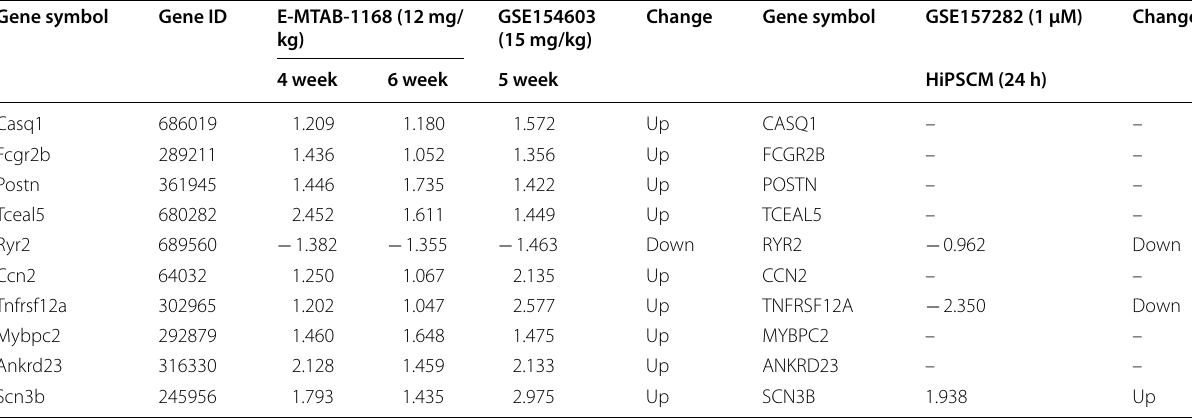
hiPSCM human induced pluripotent stem cell (hiPS)-derived